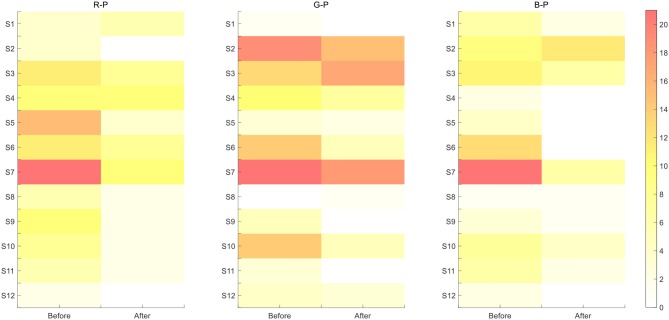
The error trials before and after modification of the model. Note: the number implies the error trials happened for one subject in one paradigm and the overall sum of trials was 240 (16 targets × 15 times); the statistical results in this section were all corrected by Bonferroni correction.